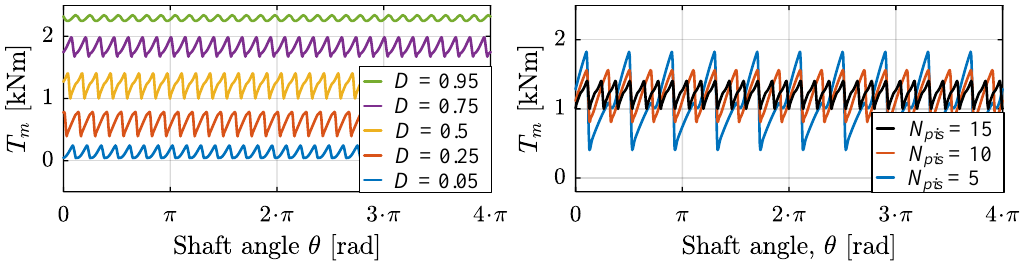
Figure 23. Steady-state response PSDS at various displacements ( left plot ) and with various numbers of cylinders ( right plot ).